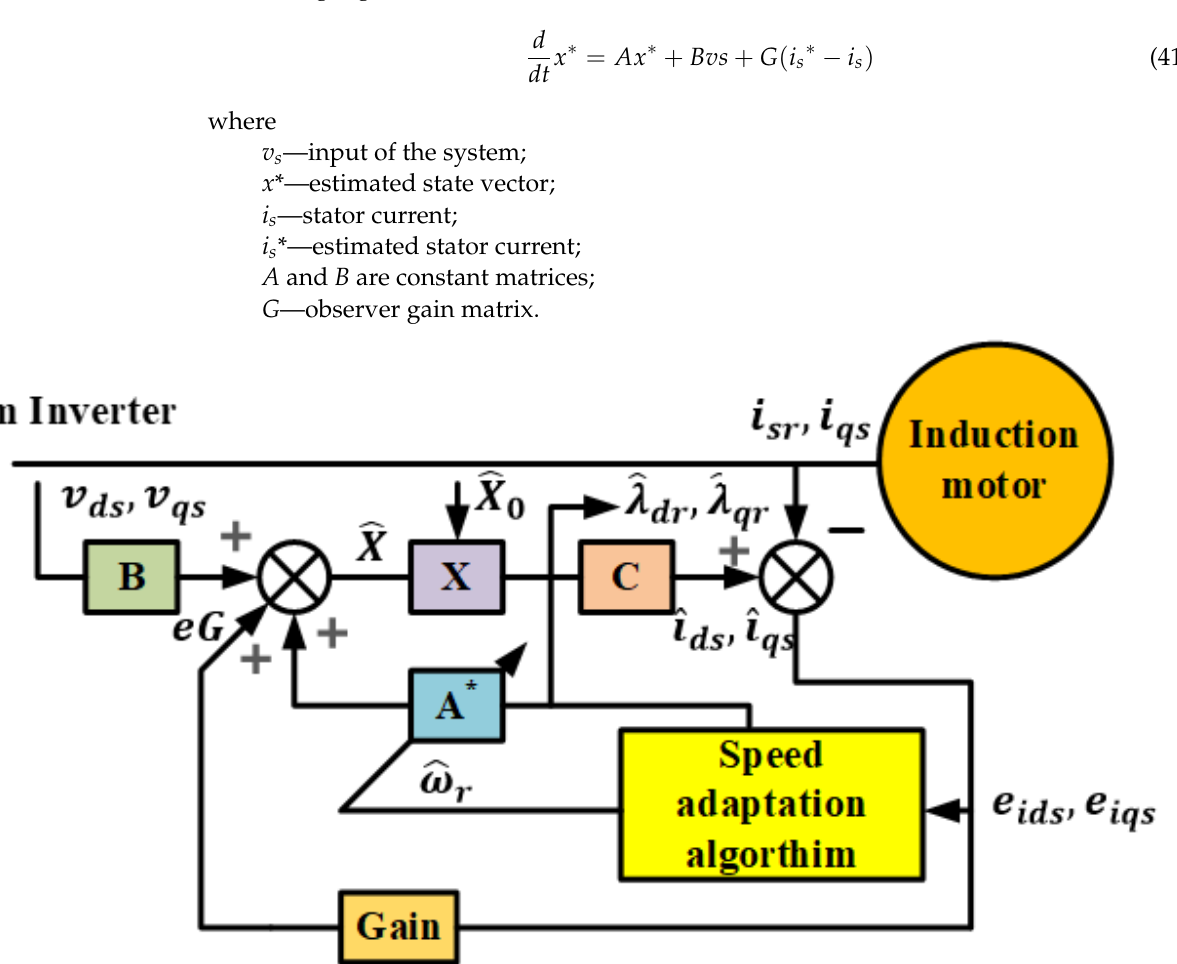
Figure 15. Adaptive flux